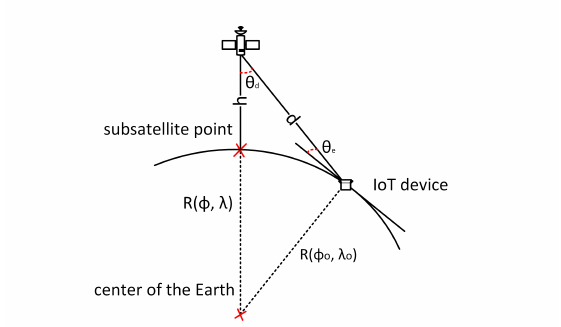
Figure 3. Explanation of the satellite down-tilt angle shown in (3). Since the satellite object is moving, the θ d becomes a time varying